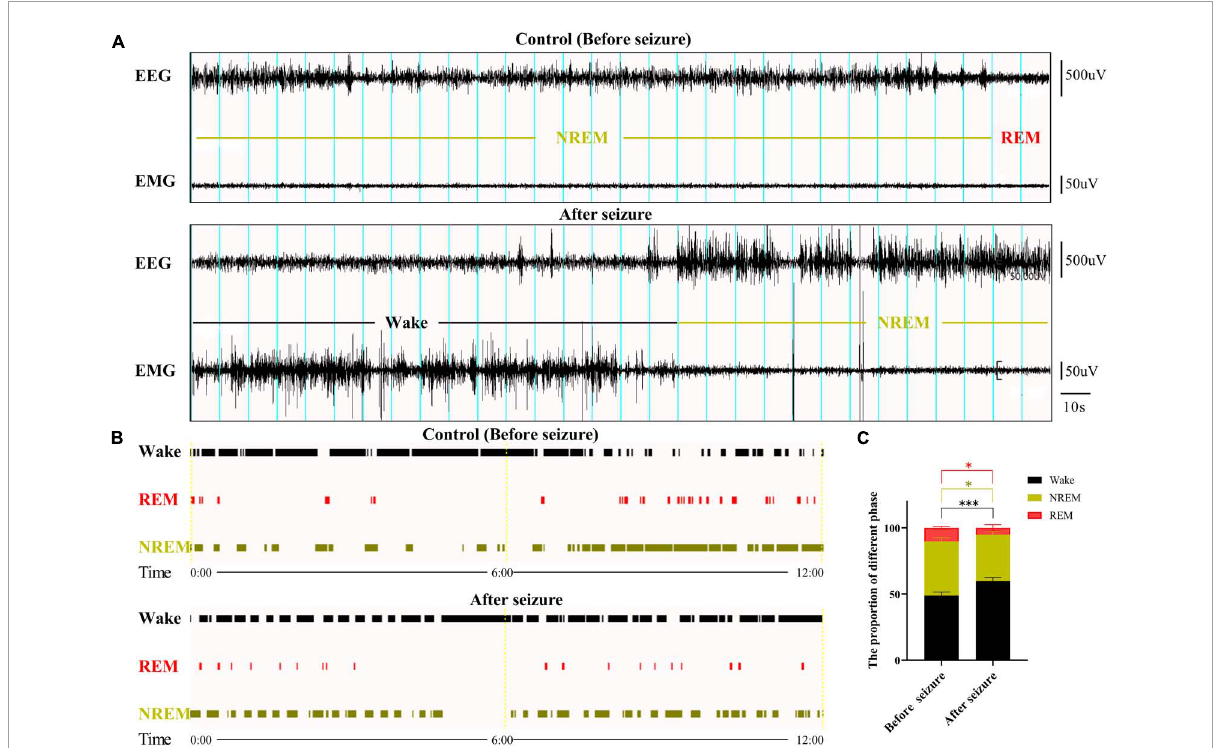
FIGURE1 Sleep-wake cycle was altered following pilocarpine-induced seizures. (A) Sleep-wake cycle was analyzed based on 24 h EEG and EMG signals collected before and after pilocarpine-induced status epilepticus (SE). Shown here are two 5 min EEG and EMG signals at 10 a.m. from a rat before and after SE, respectively. Blue lines indicate 10 s epochs. The sleep-wake state for each 10 s epoch was designated as in (B) . (C) Bar graph showing that rats displayed increased wake state and decreased REM and NREM state 1 day after SE. ∗ P < 0.05, ∗∗∗ P < 0.001, n = 3, two-way